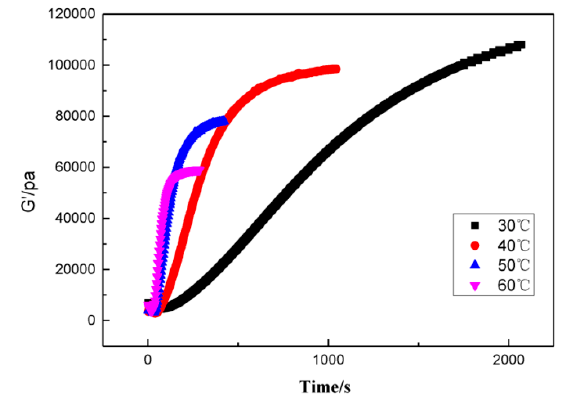
Figure 1. The change law of the storage modulus of slurries of GAPSPs with time.